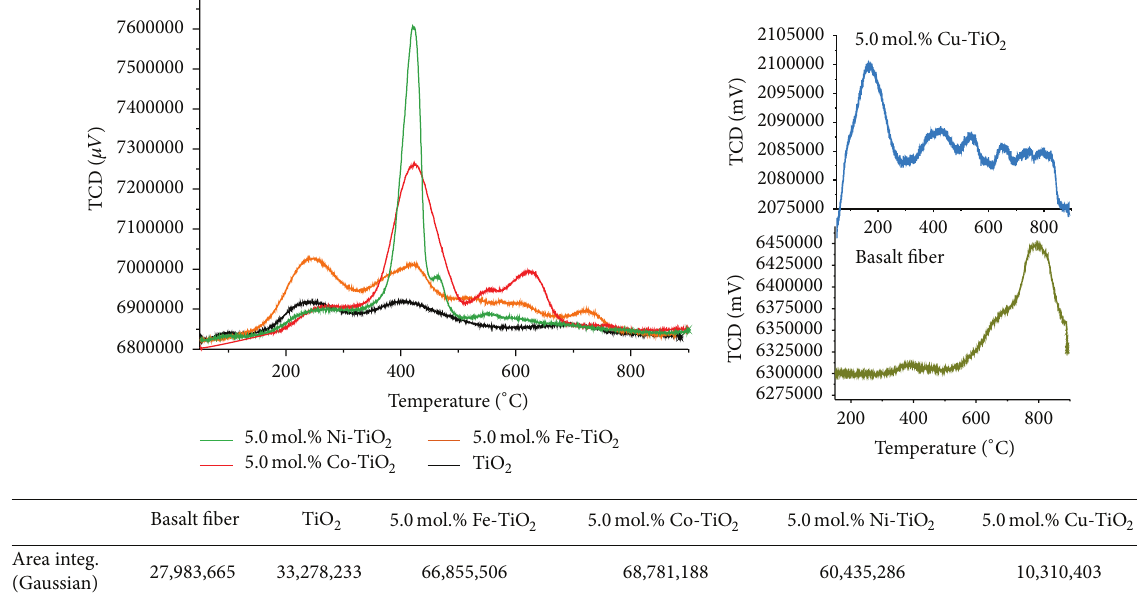
Area integ. (Gaussian) Figure 6: CO 2 desorption profiles over the 5.0 mol.% M-TiO 2 particles in the range, 50 ∼ 900 ∘